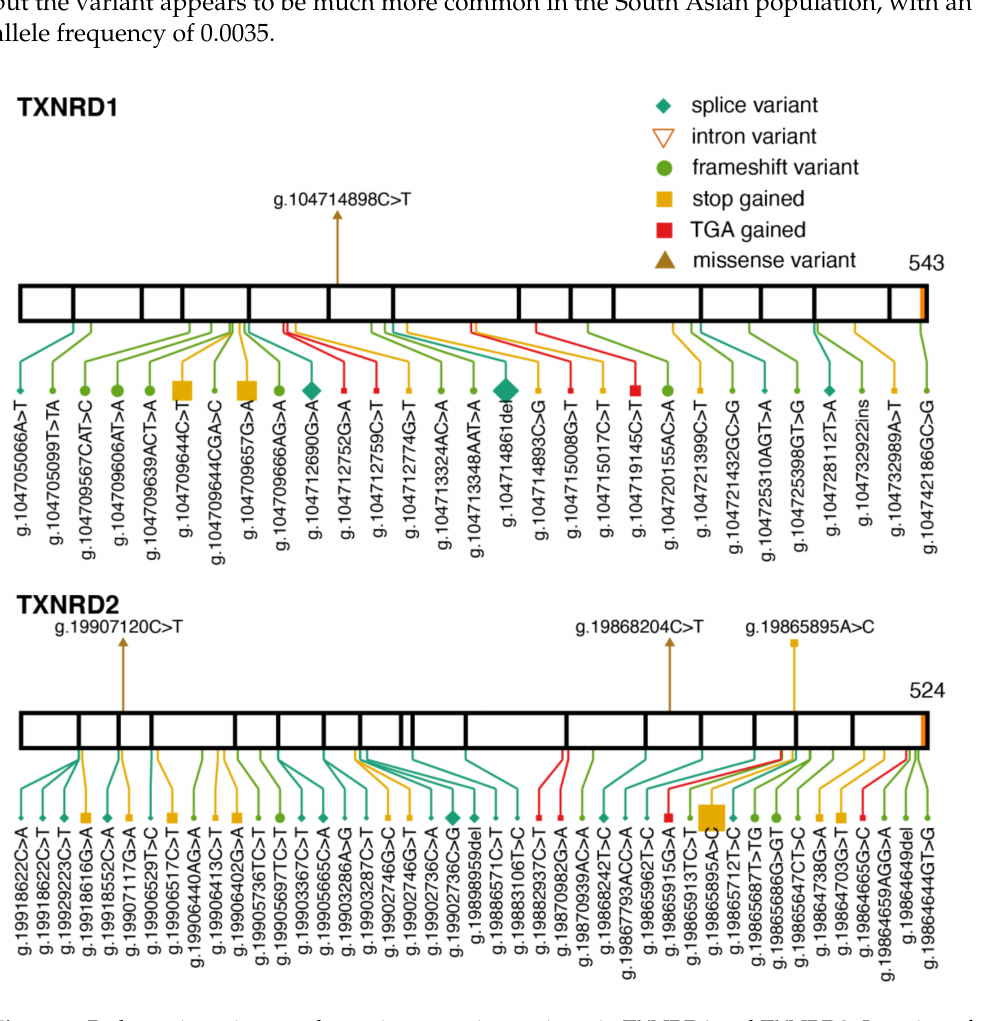
Figure 3. Pathogenic variants and protein-truncating variants in TXNRD1 and TXNRD2. Location of pathogenic variants (above) and gnomAD protein-truncating variants (below) along the TXNRD1 and TXNRD2 protein sequence. The same aesthetics as Figure 1b are used. TXNRD1 transcript: ENST00000526390; TXNRD2 transcript: